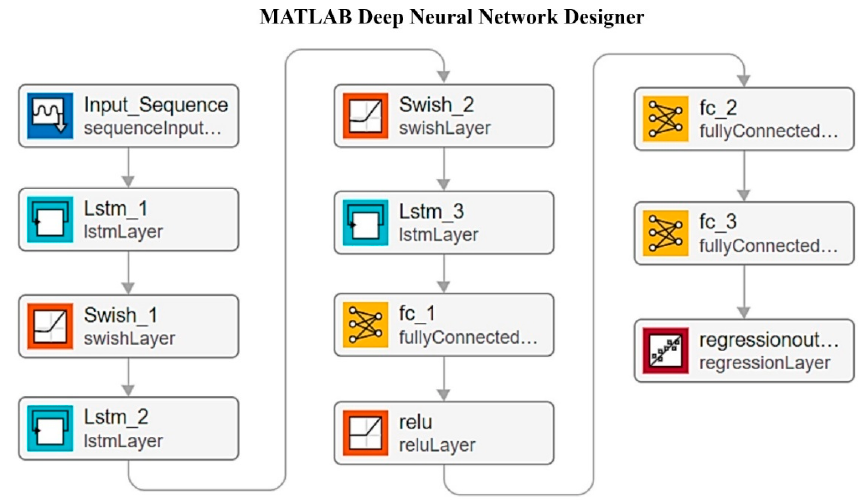
Figure 6. RNN–LSTM network architecture design with active layers.